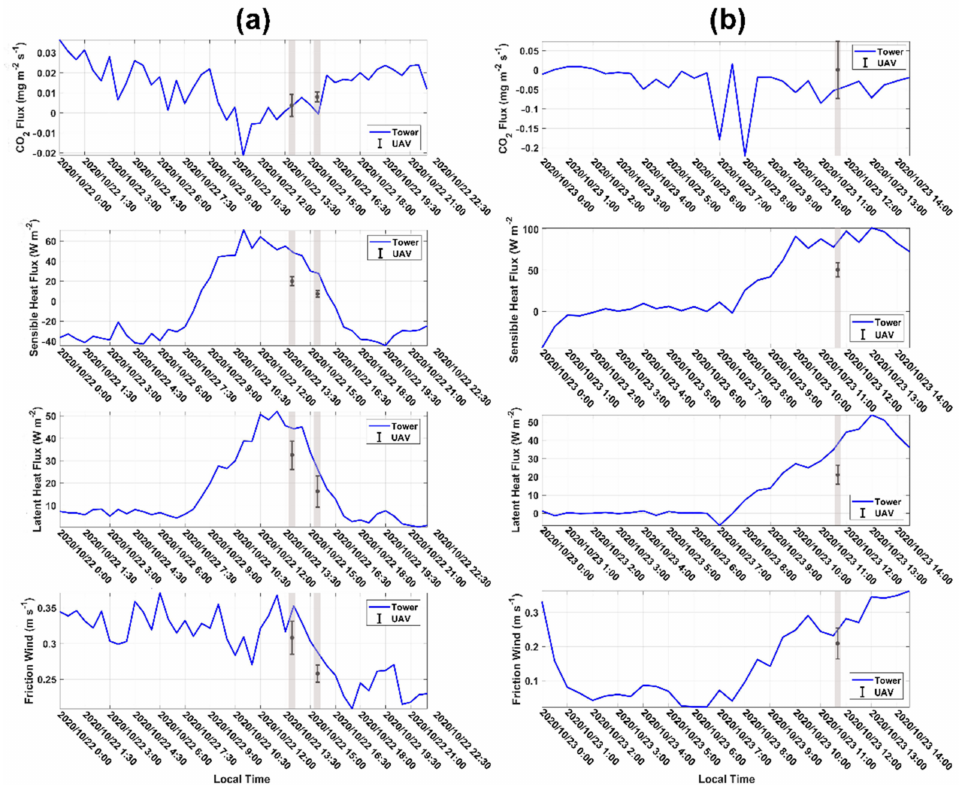
Figure 13. Comparison of the time series of the measured fluxes between the ground tower and UAV on ( a ) 22 and ( b ) 23 October 2020. The ground tower provides conventional 30 min averaged flux results, and the median time of each comparison flight was used to indicate the time of the measured fluxes from the UAV. Grey boxes show approximate times at which the comparison flights